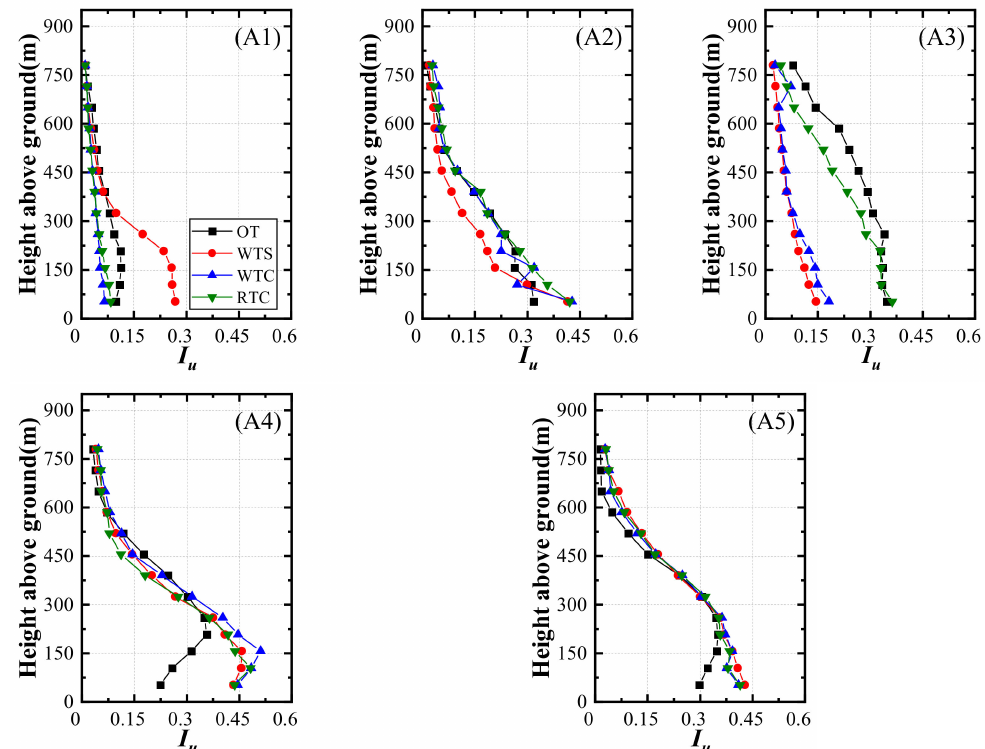
Figure 7. Profiles of turbulence intensity at measurement locations: (A1) location A1; (A2) location A2; (A3) location A3; (A4) location A4; (A5) location